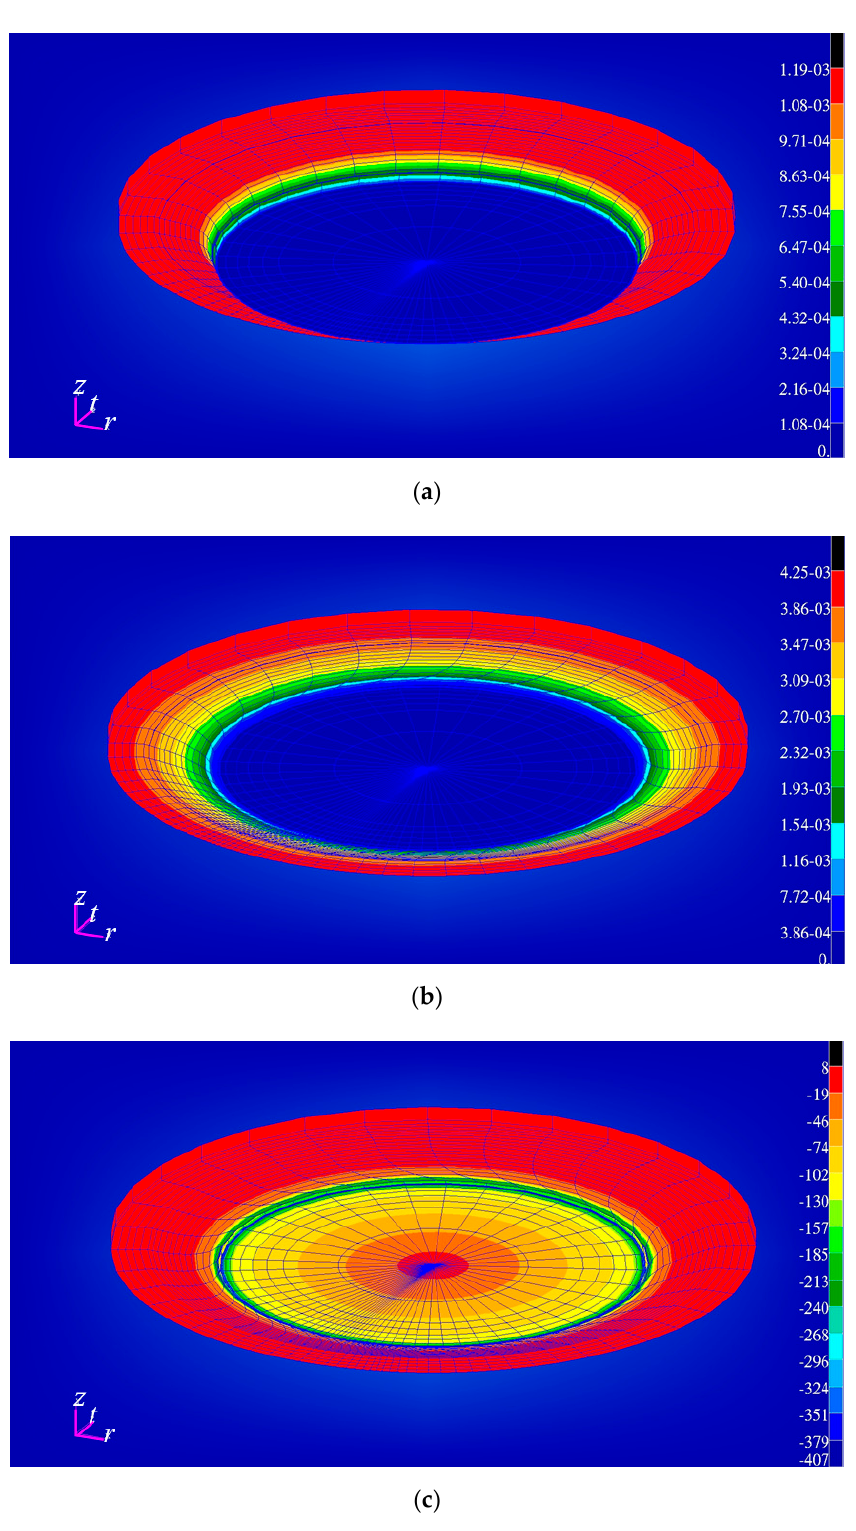
Figure 17. The contour plots of total displacement and tz -stress on the shapes deformed under the positions of the loading cycle for the RP case ( ∆ K III / ∆ K I = 1.5, δ = 90 ◦ ), ( a ) maximum deformation by mode I loading, ( b ) and ( c ) maximum deformations by mode III loading. ( a ) and ( b ) depict total displacements and ( c ) depicts tz -stress. Notably, the contour levels for displacement in mm and for stress in MPa. Deformation amplifications are 1000×.